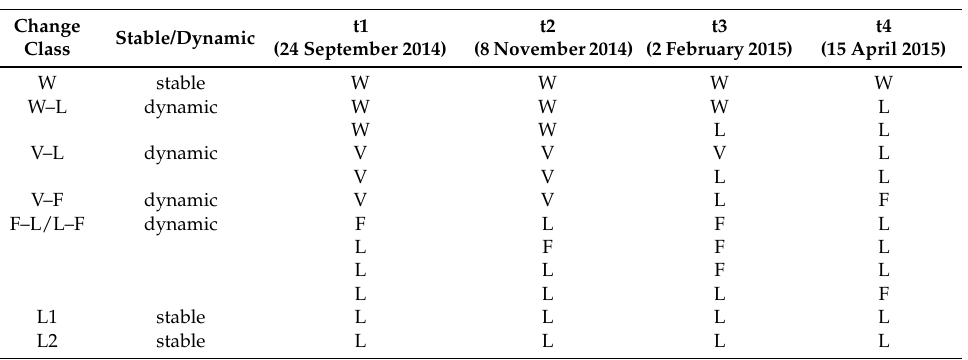
Table 3. Change processes at Lac Bam from the rainy to the dry season, illustrated for the four time steps: 24 September 2014 (t1), 8 November 2014 (t2), 2 February 2015 (t3), and 15 April 2015 (t4): W (water), V (flooded/floating vegetation), F (irrigated fields), L (dry land), main change processes are marked